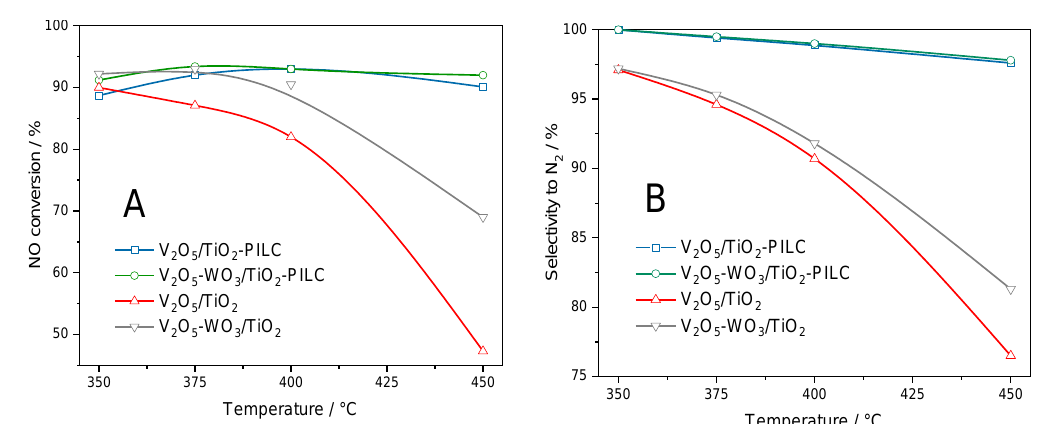
Figure 5. Results for NH 3 -SCR tests over V 2 O 5 /TiO 2 -PILC and V 2 O 5 –WO 3 /TiO 2 -PILC catalysts ( A ) and V 2 O 5 –TiO 2 and V 2 O 5 –WO 3 –TiO 2 metal oxides as refence catalysts ( B ). Reaction conditions: 0.3 g catalyst, [NO] = [NH 3 ] = 1000 ppm, [O 2 ] = 2%, He = balance, total flow rate = 500 mL min − 1 , and GHSV = 75,000 h − 1 . Based on the results presented in [49] with permission from ref. [49]. Copyright 2000 Elsevier.